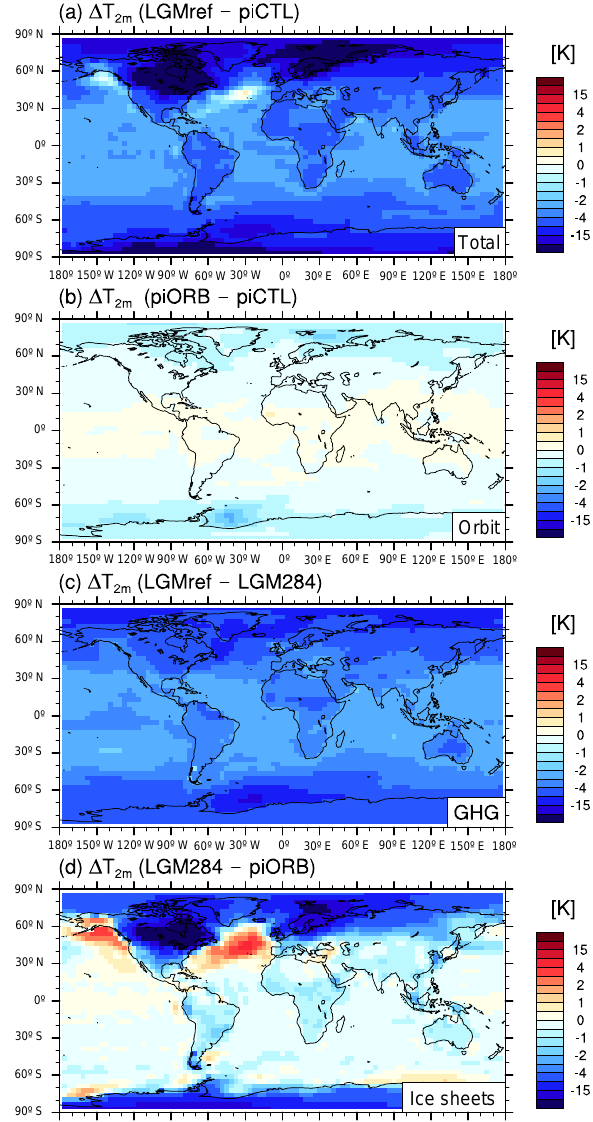
Figure 1. 2m air temperature differences in response to (a) the to- tal glacial forcing (LGMref – piCTL), (b) the orbital configuration (piORB – piCTL), (c) the glacial GHG concentrations (LGMref – LGM284) and (d) the ice sheets (LGM284 –